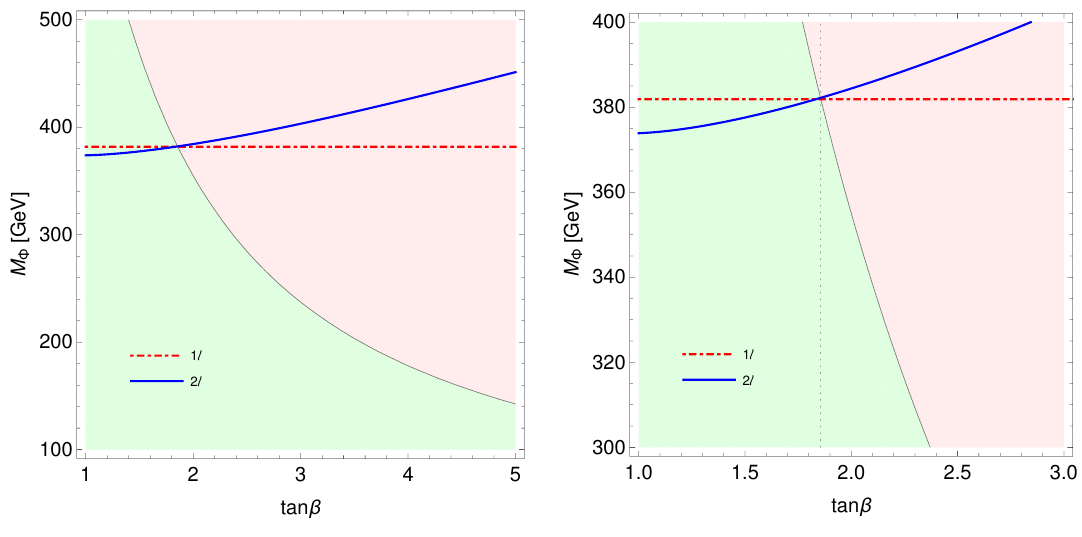
Figure 10 . Regions of the tan β and M Φ parameter space of the CSI-2HDM allowed (light green) and excluded (light red) by the requirement of tree-level perturbative unitarity [111]. Additionally, the red and blue curves give the values of M Φ computed at respectively one and two loops using equation (4.21) as a function of tan β . The right-hand side plot is an enlargement of the left- hand